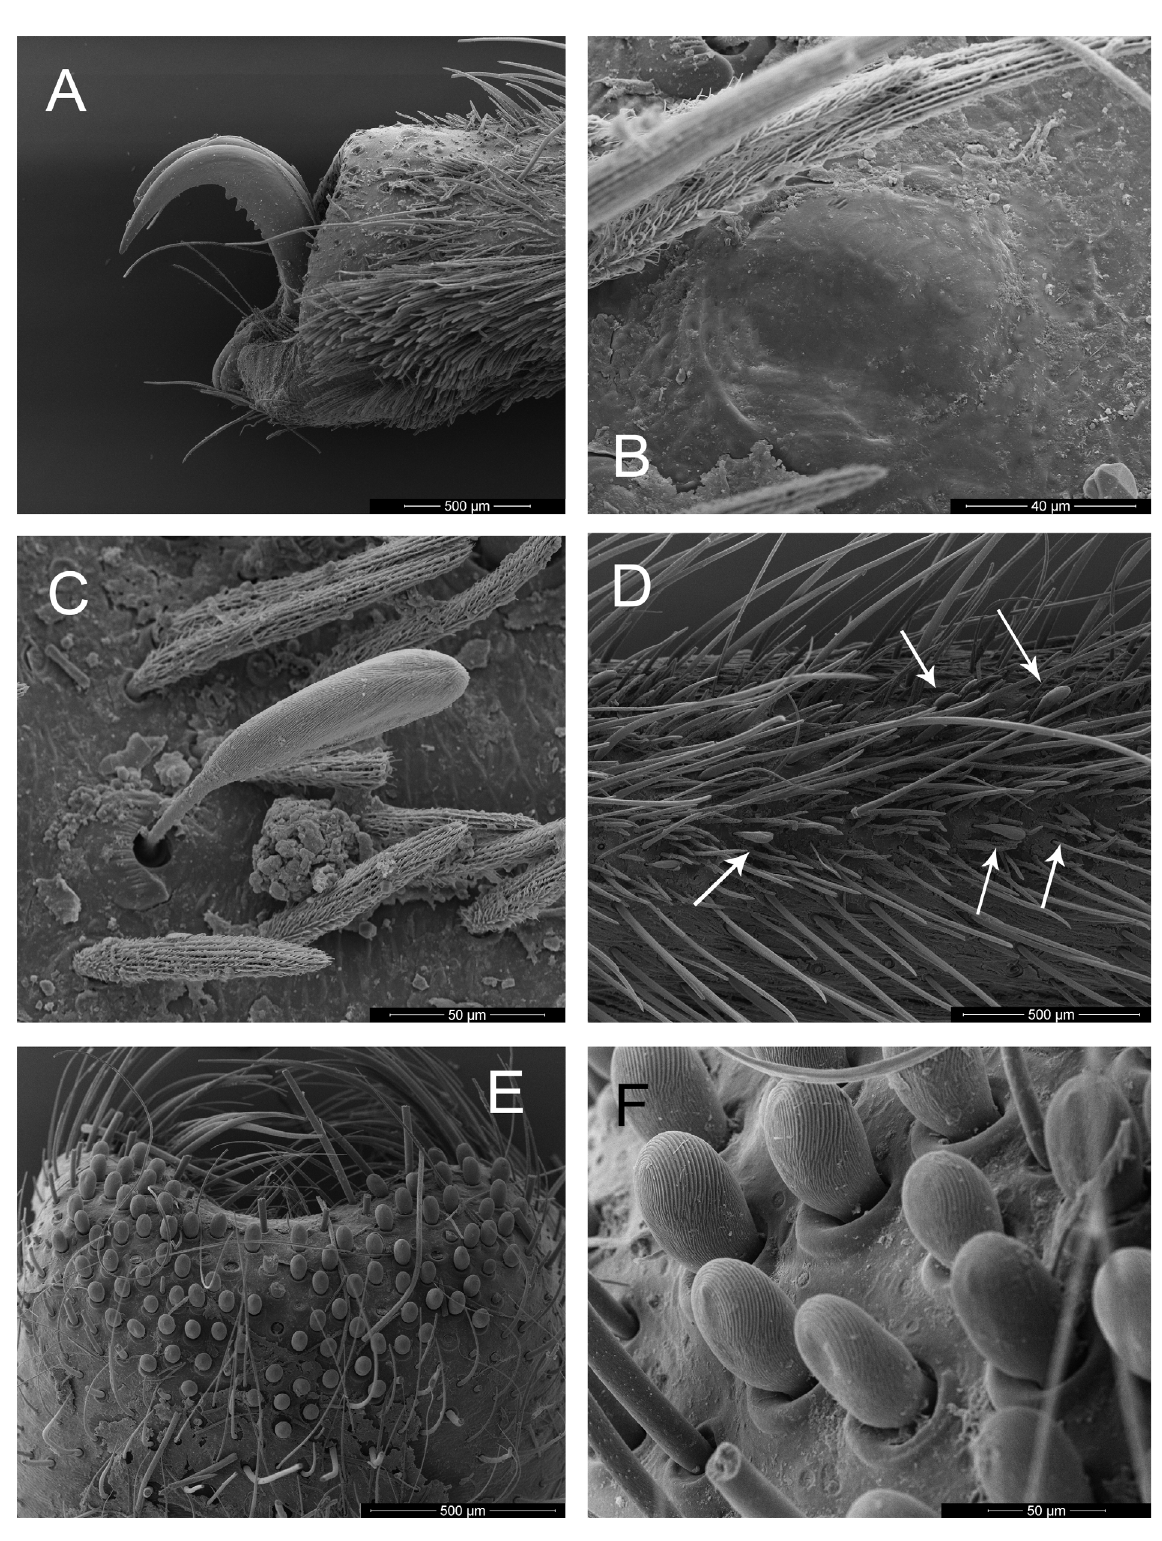
Fig. 6. Umbyquyra tucurui gen. et sp. nov., ♂, from Tucuruí, Pará, Brazil (IBSP 104716). A . Tarsal claws, leg I, prolateral view. B . Tarsal organ, dorsal. C . Trichobothrium, tarsi I, lateral. D . Row of trichobotria, tarsi I, dorsal (arrows indicate the trichobothria). E . Labium, ventral. F . Cuspules of labium,